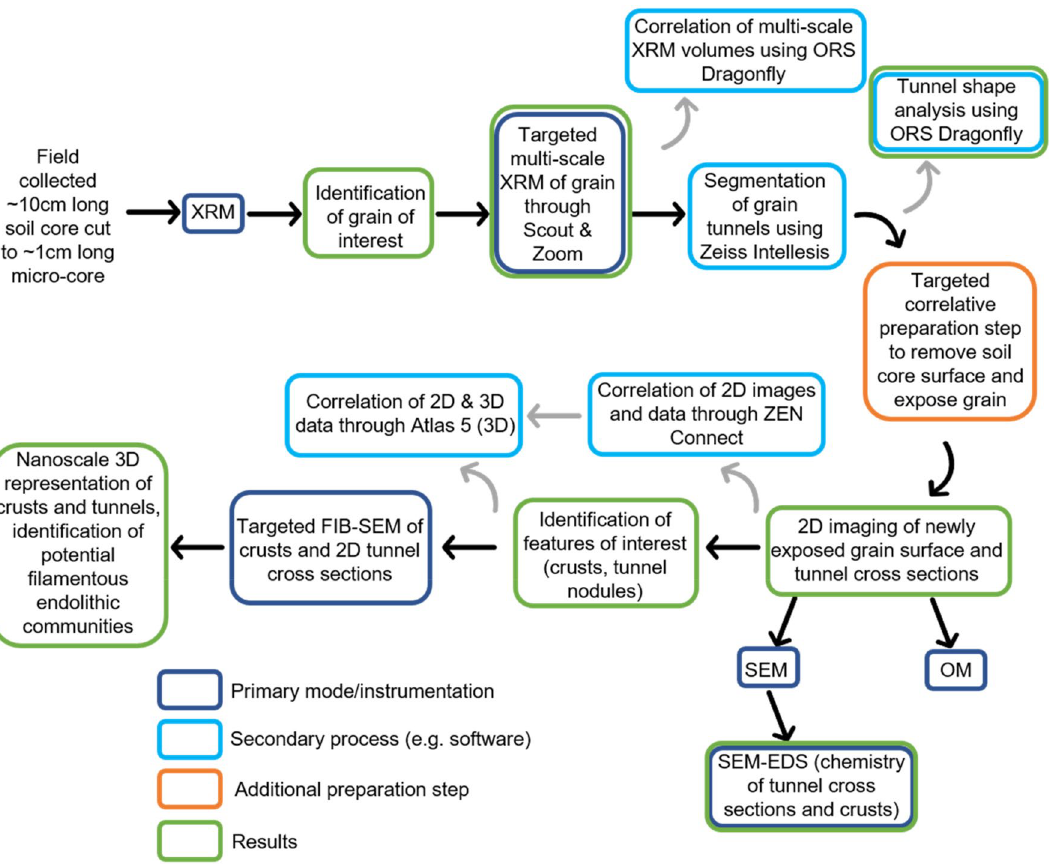
Figure 7. Flowchart summarising the targeted correlative workflow employed in this